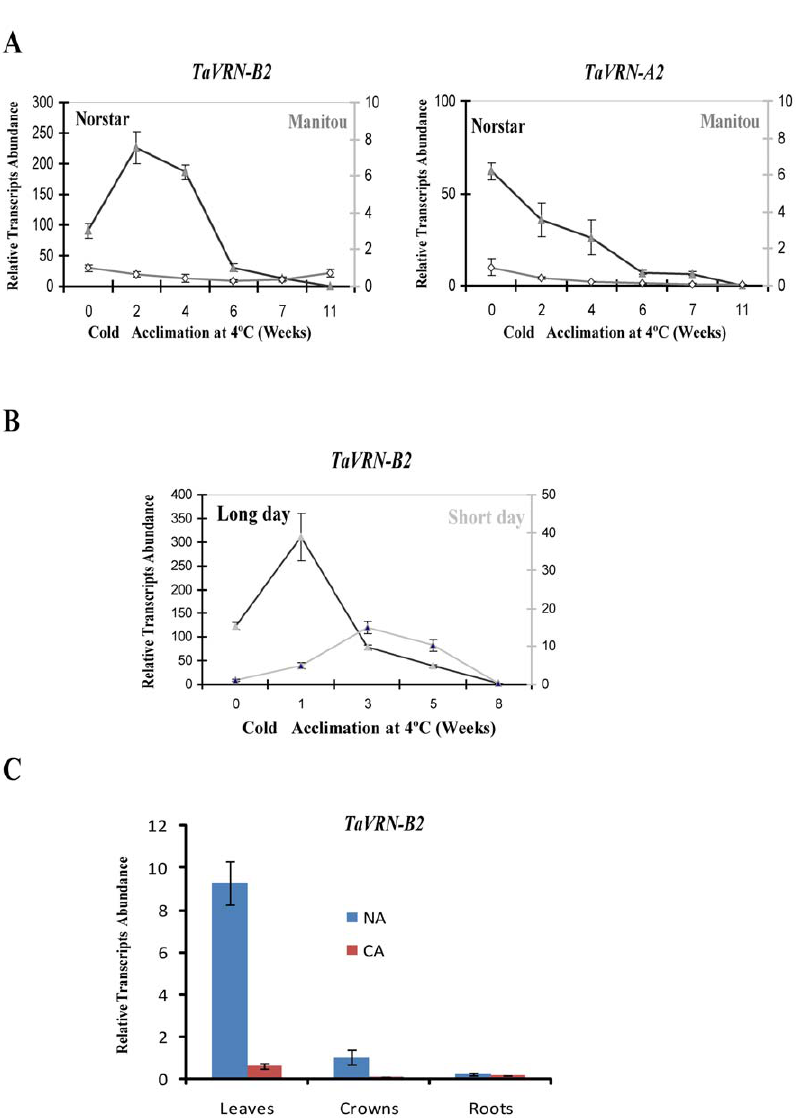
Figure 2. Transcripts level of TaVRN-B2andTaVRN-A2 in both spring and winter wheat during cold acclimation. A) TaVRN-B2 and TaVRN- A2 , in cold acclimated plants. Wheat plants were grown for 14 days at 20 u C under a long day (16 h) photoperiod, transferred to 4 u C under identical photoperiods, and then sampled at regular intervals. B) TaVRN-B2 in cold acclimated plants under short day and long day conditions. Winter wheat plants were grown for 14 days at 20 u C under either a long day (16 h) or a short day (8 h) photoperiod, transferred to 4 u C under identical photoperiods, and then sampled at regular intervals. qRT-PCR were done using total reverse-transcribed RNA isolated from wheat aerial part. C) TaVRN-B2 relative transcripts abundance in different tissues. Winter wheat were grown for 7 days at 20 u C. Non-acclimated control plants (NA) were maintained at 20 u C for 6 days. Cold-acclimated plants (CA) were transferred at 4 u C for 36 days. Total RNA was isolated from leaves, crown and roots, reverse-transcribed and subjected to qRT-PCR. Data shown represent mean values obtained from independent amplification reactions (n=4), and the error bars indicate the range of possible RQ values define by the SE of the delta threshold cycles (Cts). Experiment was repeated three times with similar